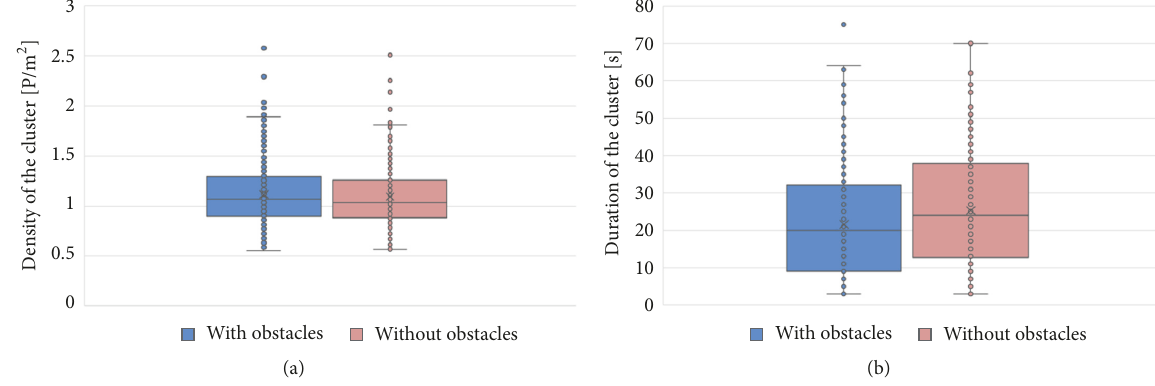
Figure 6: Box plots of the duration (a) and the density (b) of the clusters, analysing the cases with and without obstacles.